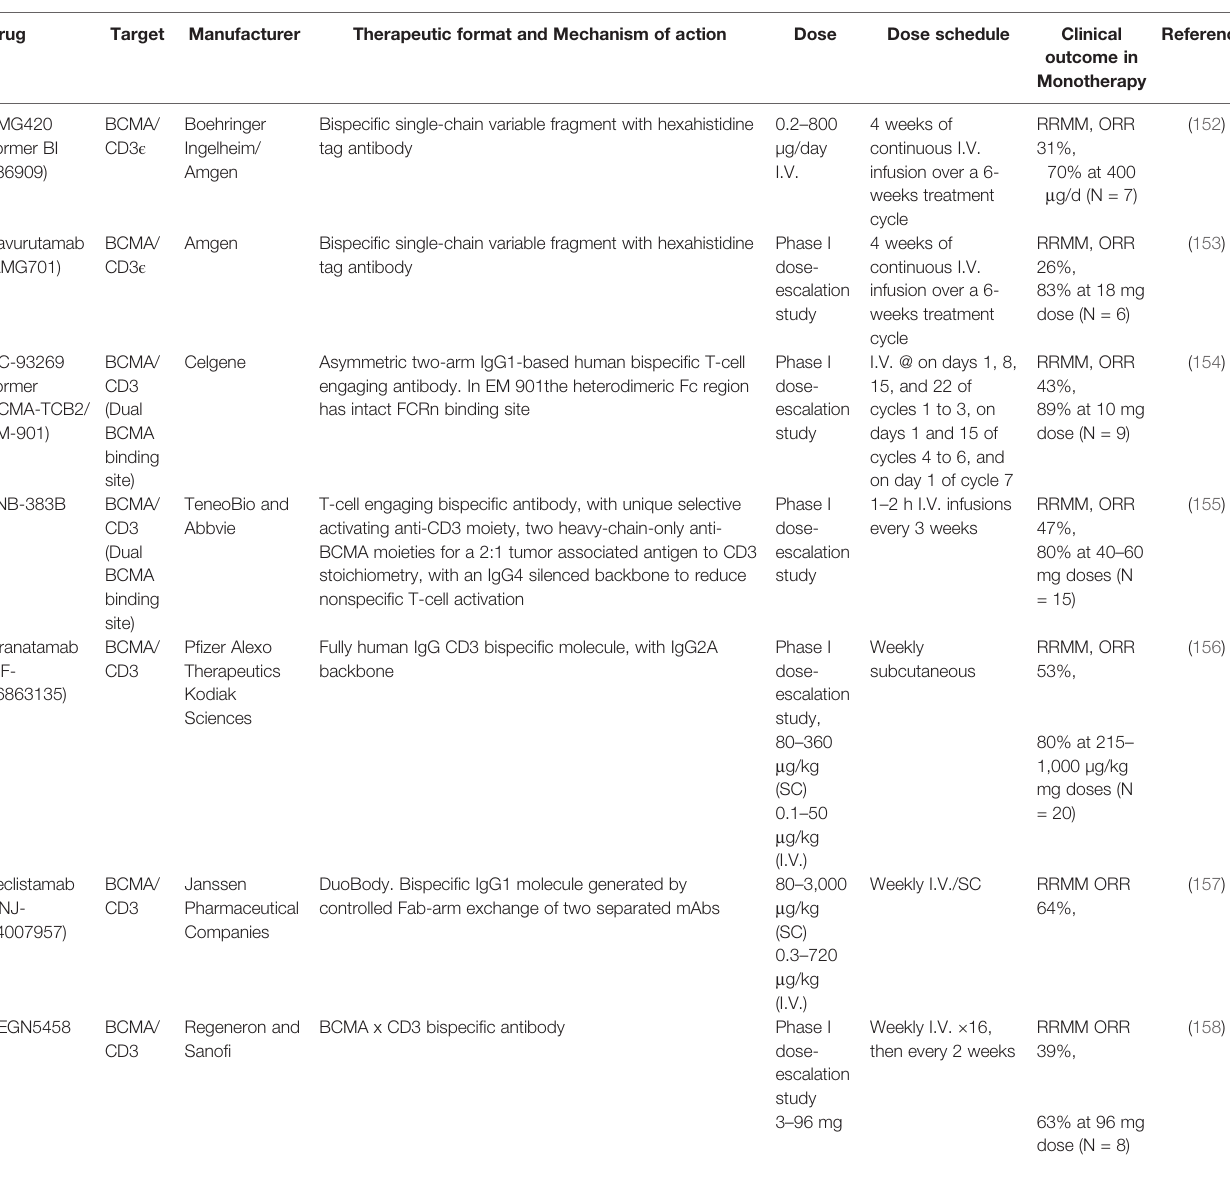
TABLE 3 | BsAbs against BCMA in clinical development (Major clinical trials with published